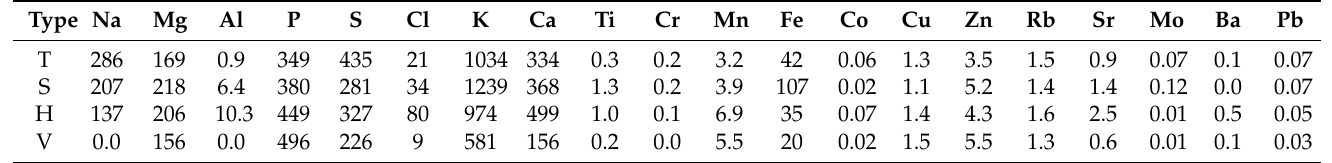
Table 2. Mineral elements in cultivar with respect to plant type (mg/100